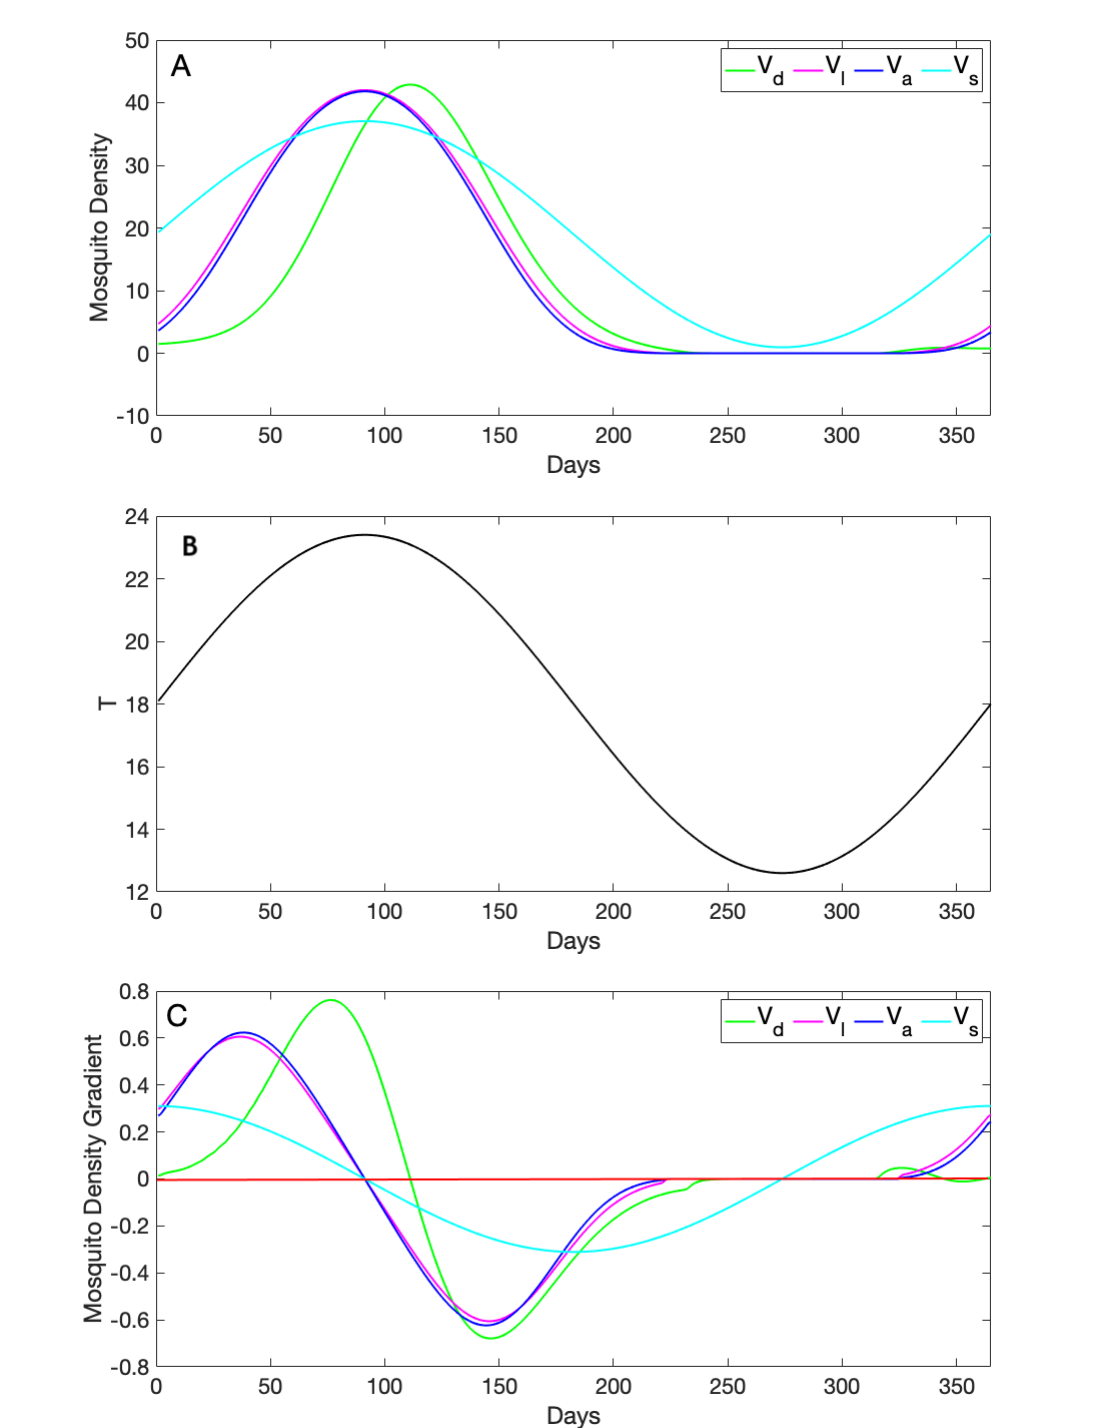
Figure 5. ( A ) Daily adult female mosquito densities approximated using four forms, namely the sine wave V s with initial V 0 = 19 and amplitude of 0.95, the adult trait-dependent form V a , the life stage trait-dependent V l , and the dynamical density V d ; the parameter values used to solve the ode model are given in Table 1. ( B ) Daily temperature given by a sine function ( T 0 ( 1 + B sin ( 2 π t /365 ) with T 0 = 18 and B = 0.3) evaluated for 365 days used to evaluate our thermal traits incorporated into the dynamical model. ( C ) Densities’ first derivatives calculated to show how each curve changes its gradient as it varies with temperature. The red line shows when the gradient is zero; positive gradient values (above the red line) mean that the density increases; and negative values of the gradient (below the red line) mean that the curve